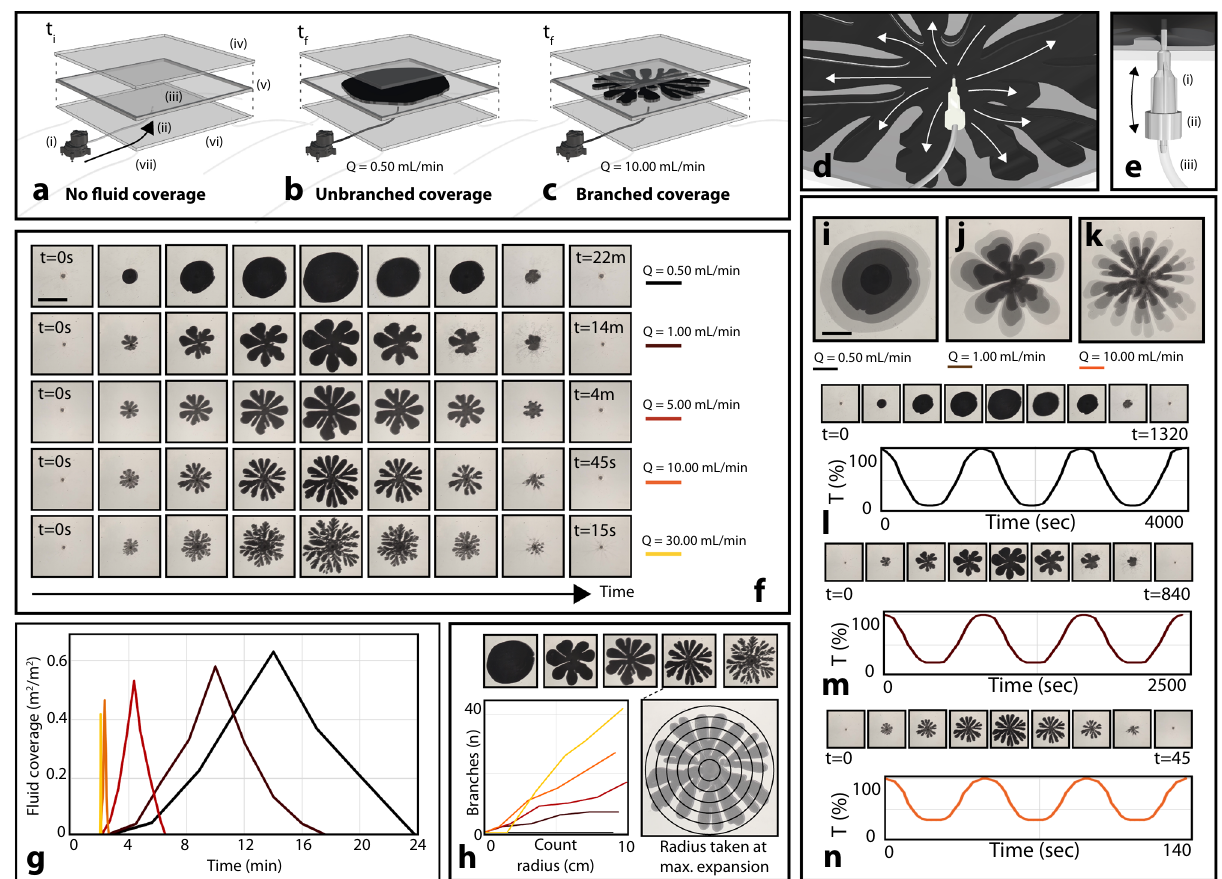
Fig. 2 Tuning shading coverage by actively controlling pigment morphology. a – c Schematic of a single fl uidic cell, with no pigment fl uid coverage ( a ), unbranched pigment fl uid coverage ( b ), and branched pigment fl uid coverage ( c ). System components: (i) digitally controlled peristaltic pump; (ii) inward fl uidic pigment fl ow with pressure; (iii) active fl uidic pigment layer, 1mm thick; (iv) fi rst rigid plate; (v) outer gasket; (vi) second rigid plate; (vii) drain tubing for temporary fl uid displacement. d Demonstrating the branching of pigment fl uid when introduced at higher speed. e Inlet design: (i) needle; (ii) luer connector; (iii) hose connector. f Reversible pigment injection/withdrawal, where degree of branching is determined by injection fl ow rate (Q) from 0.5 – 30mL/min. Scale bar is 15cm. g Fluid coverage as a function of time for experiments pictured in ( f ). h The number of fl uidic branches increases with fl ow rate. All measurements taken once pigment fl uid fully dispersed. i – k Overlayed images of pigment fl uid dispersal over time for three different fl ow rates. Scale bar is 5cm. l – n Cyclical light transmission measurements across three pigment fl uid dispersal and contraction cycles. Images represent fi rst cycle. Light intensity varies for each system at full actuation. Because maximum light intensity was set to 100 lux, plots in ( l – n ) additionally display relative measured interior light intensity behind each cell in